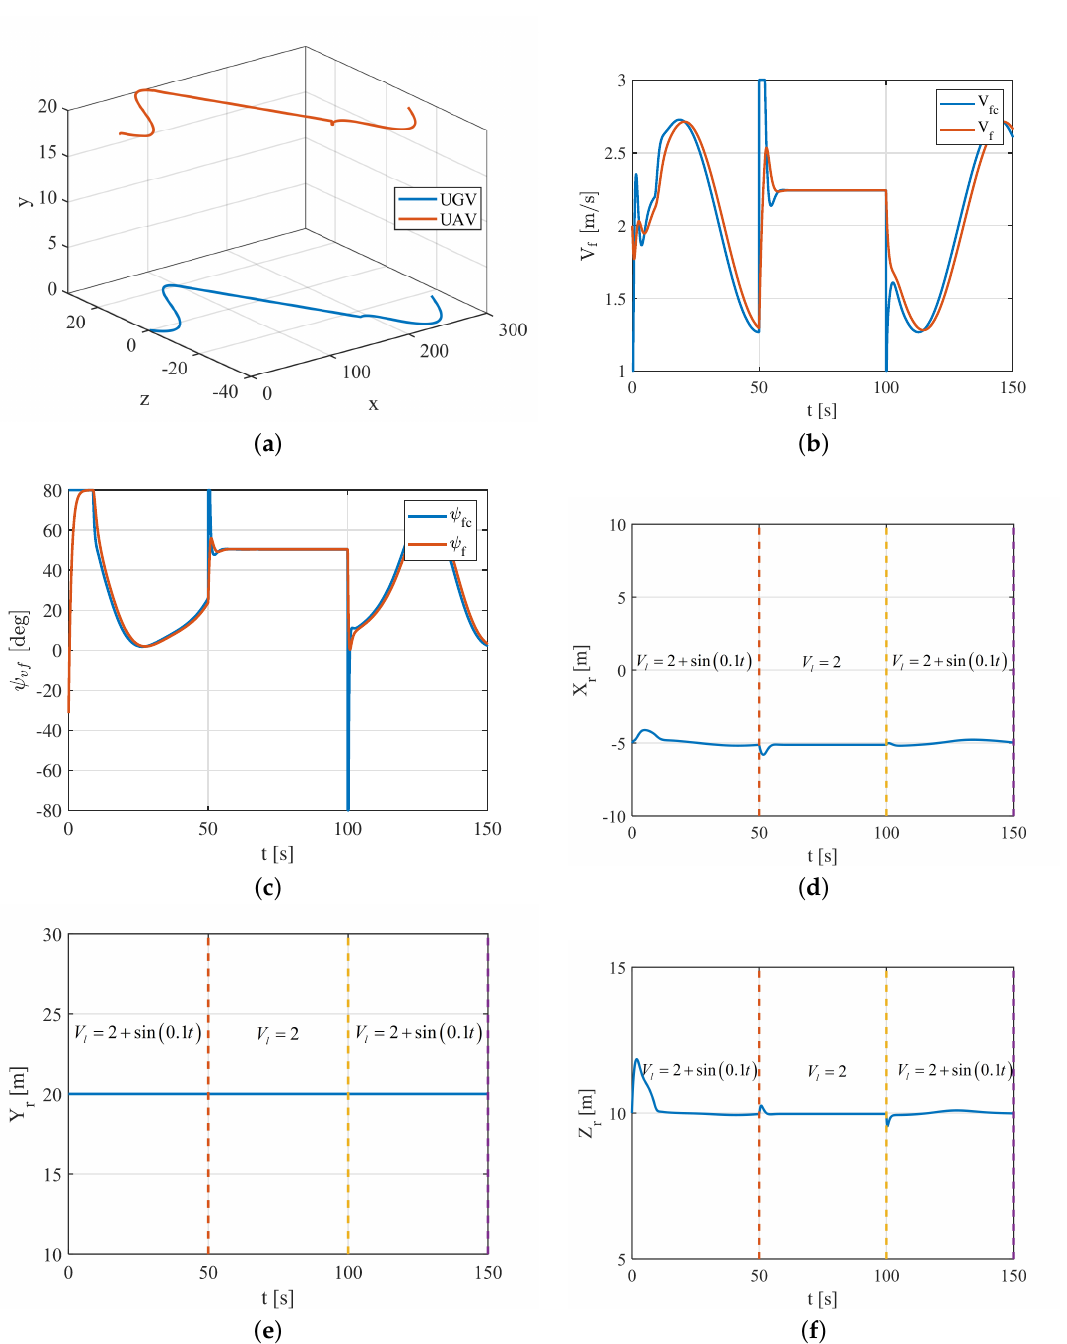
Figure 1. Simulation results of case 1. ( a ) Three-dimensional motion trajectory of UGV and UAV; ( b ) velocity of UAV; ( c ) deflection angle of UAV; ( d ) motion trajectory in X r -axis direction; ( e ) motion trajectory in Y r -axis direction; ( f ) motion trajectory in Z r -axis